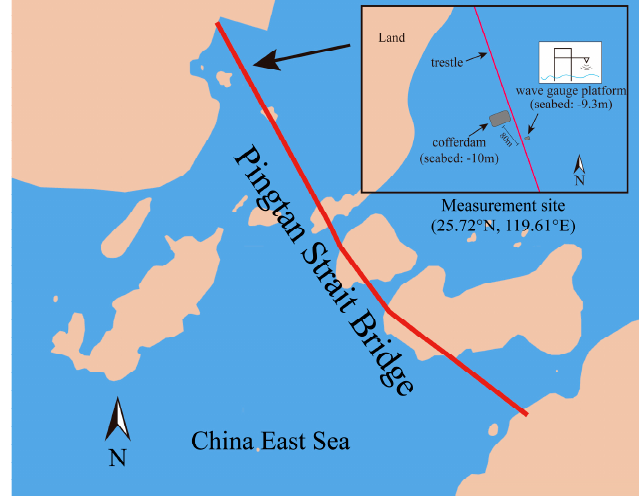
Figure 1. The on-site measurement location and layout.